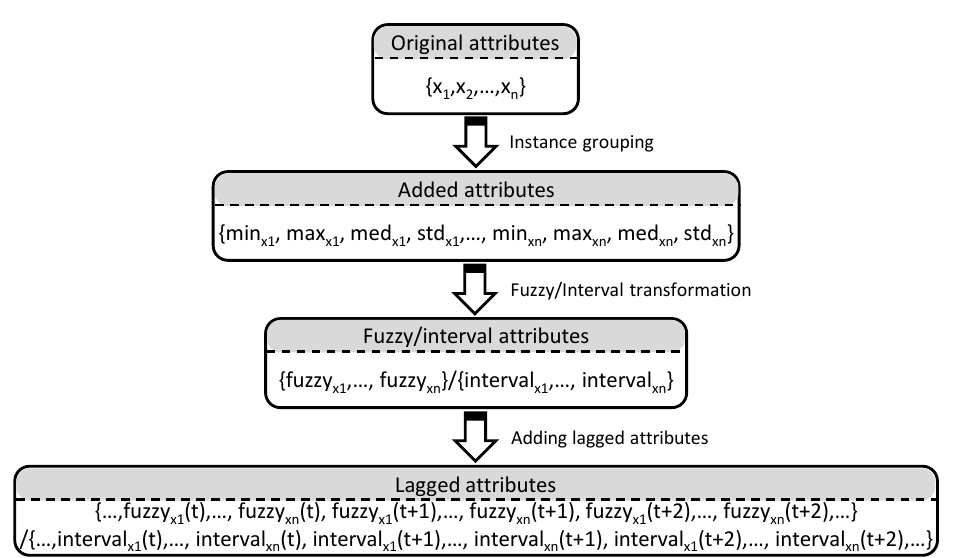
Figure 3. Methodology for preprocesing